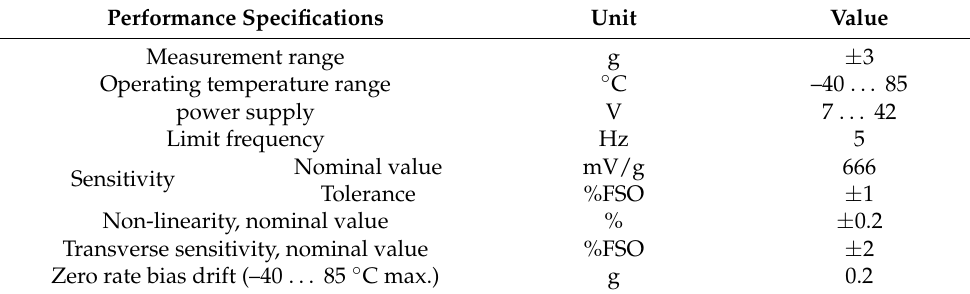
Table 2. Basic technical data of the TAA linear acceleration sensor